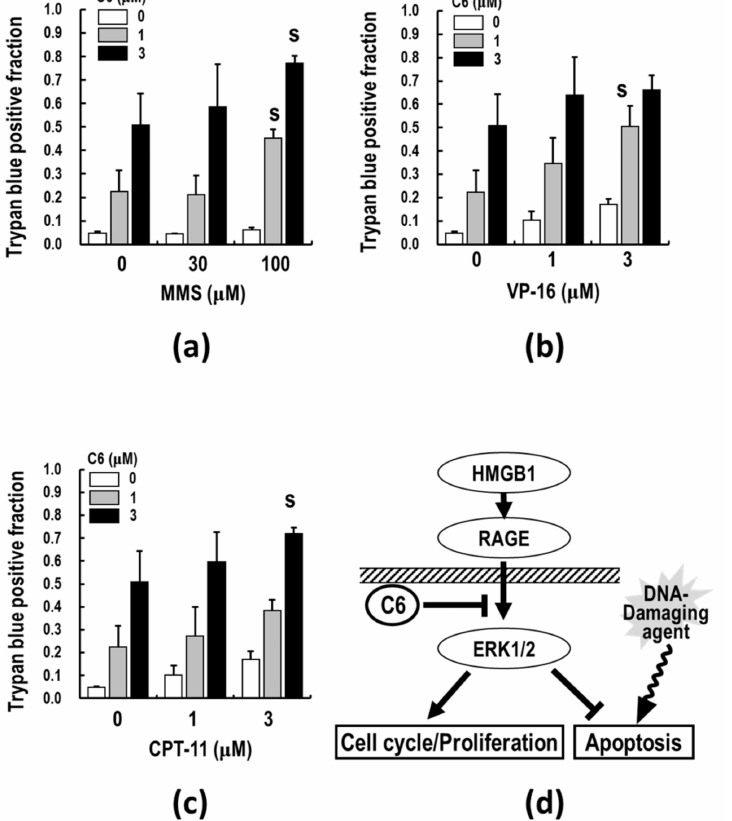
Figure 7. The effect of C6 on cell death induction along with DNA-damaging agents in HCT116 cells. HCT116 cells were co-treated with C6 and MMS ( a ), VP-16 ( b ), or CPT-11 ( c ) at the indicated concentrations for 48 h. Cell death was measured by trypan blue dye exclusion as described in Section 4. The synergy analysis of the combined effects was performed by excess-over-Bliss additivism (EOBA) analyses. Data are presented as mean ± SE of three independent experiments. S represents a synergistic effect. ( d ) Schematic illustrating the suppressive effects of C6 on cell cycle/proliferation and apoptosis via HMGB1-RAGE-ERK1/2 axis and the combination effects of DNA damaging agents on apoptosis induction in cancer